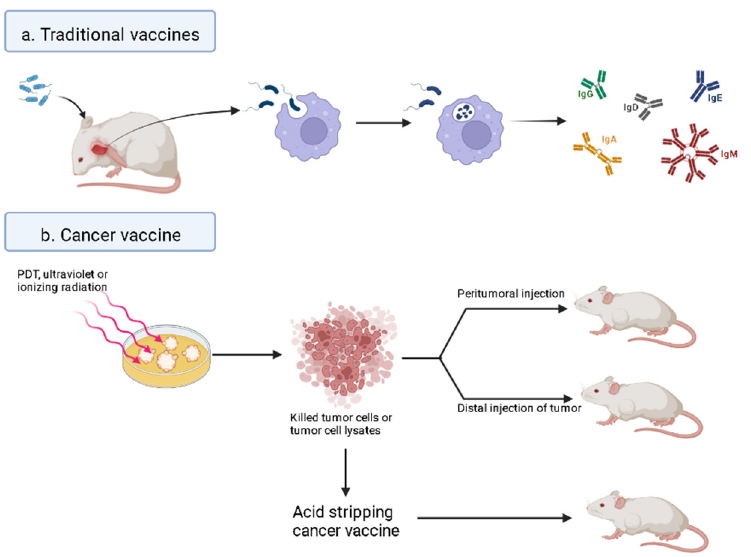
Figure 3. Cancer vaccines. ( a ) Traditional vaccines. The body recognizes foreign invading pathogens, activates the immune system, and produces a large number of antibodies to kill the pathogens. ( b ) Cancer vaccines. PDT induces killed tumor or cell lysates, production of vaccines using antigenic peptides for delivery back into the body through the injection around the tumor or the remote injection of the tumor to activate the immune system.